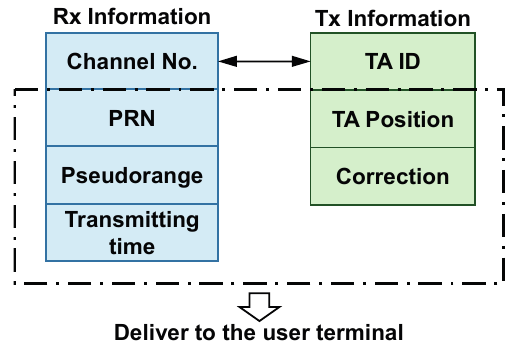
Figure 3. Rx and Tx information and information matching.